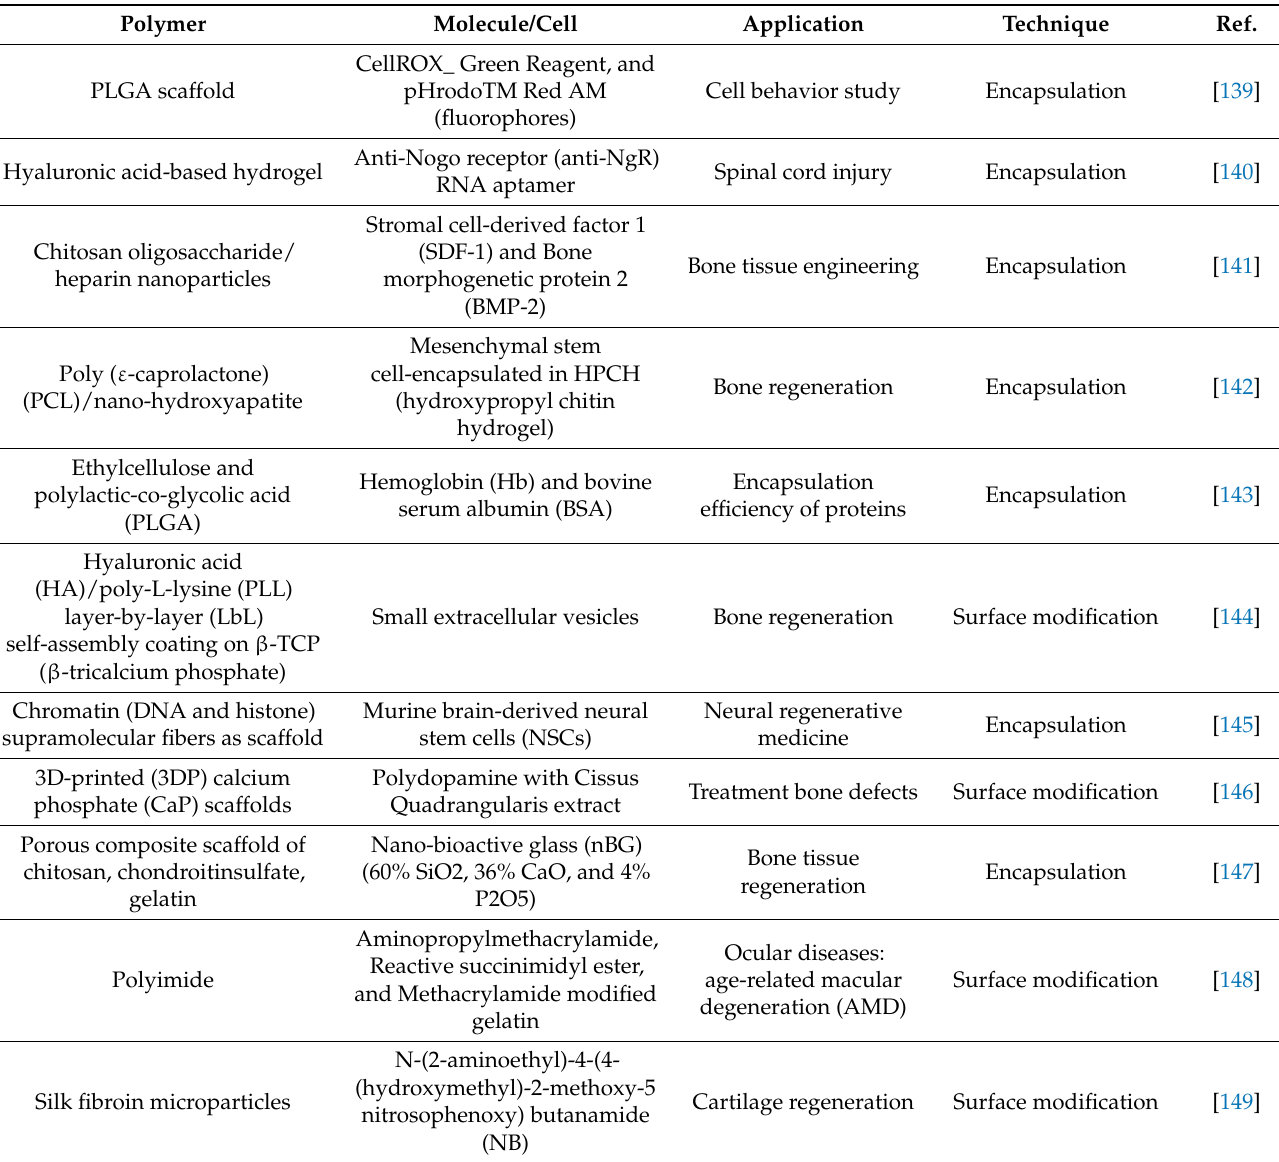
Table 2. Different strategies for modification of scaffolds to promote their